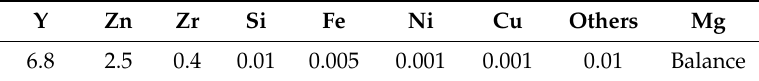
Table 1. Chemical composition of Mg–6.8Y–2.5Zn–0.4Zr (wt%) alloy determined via optical